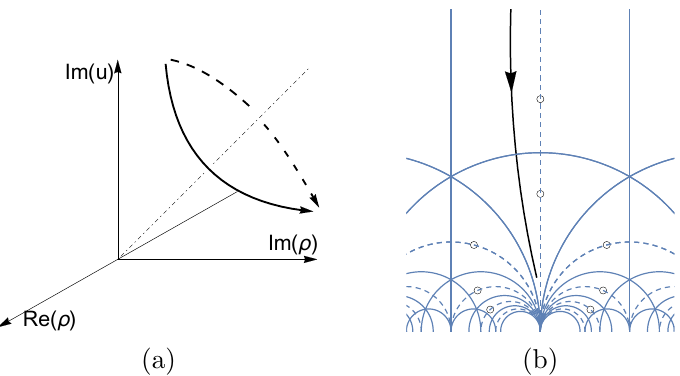
Figure 3 . The paths ˜ γ ˜ σ and ˜ γ are shown by the solid and dashed curves, respectively, in the ˜ σ − 1 Im( u ) = 0 slice of the ( ρ, u ) ∈ C 2 space in (a); the u = ρ singularity is shown by the dot-dashed line. The panel (b) shows the path ˜ γ ˜ g in the ρ = ρ ( u ) slice of the ( ρ, u ) parameter space. The 0 2( u ) singularity at u ∈ PSL 2 Z · ρ ( u ) are marked by the open 0